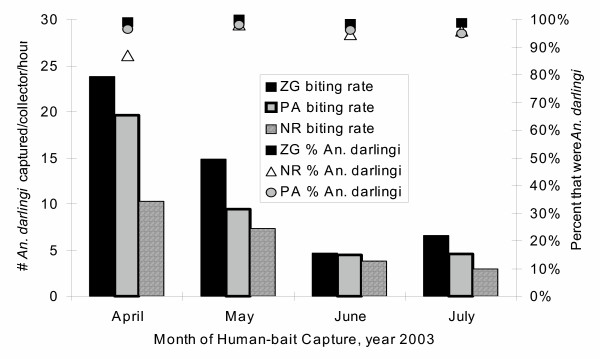
Mean An. darlingi captured, prepared to bite/person/hour and percent of mosquitoes that were An. darlingi. Captures were conducted by mechanical aspiration from 7–11 pm (the known peak biting time), on the porch of households4. An. darlingi are known to bite in and near human households[4]. There were 10 MINSA entomologists, working in pairs, to give a total of 5 entomologic captures/night. The households were chosen from the sentinel houses in at-risk zones selected for human infection surveillance. In at-risk zones where there were more than 5 houses, 5 of the sentinel houses were randomly selected for entomologic captures. Each month, 5 at-risk zones were included, with 5 houses each, for 4 weekly captures in each house.